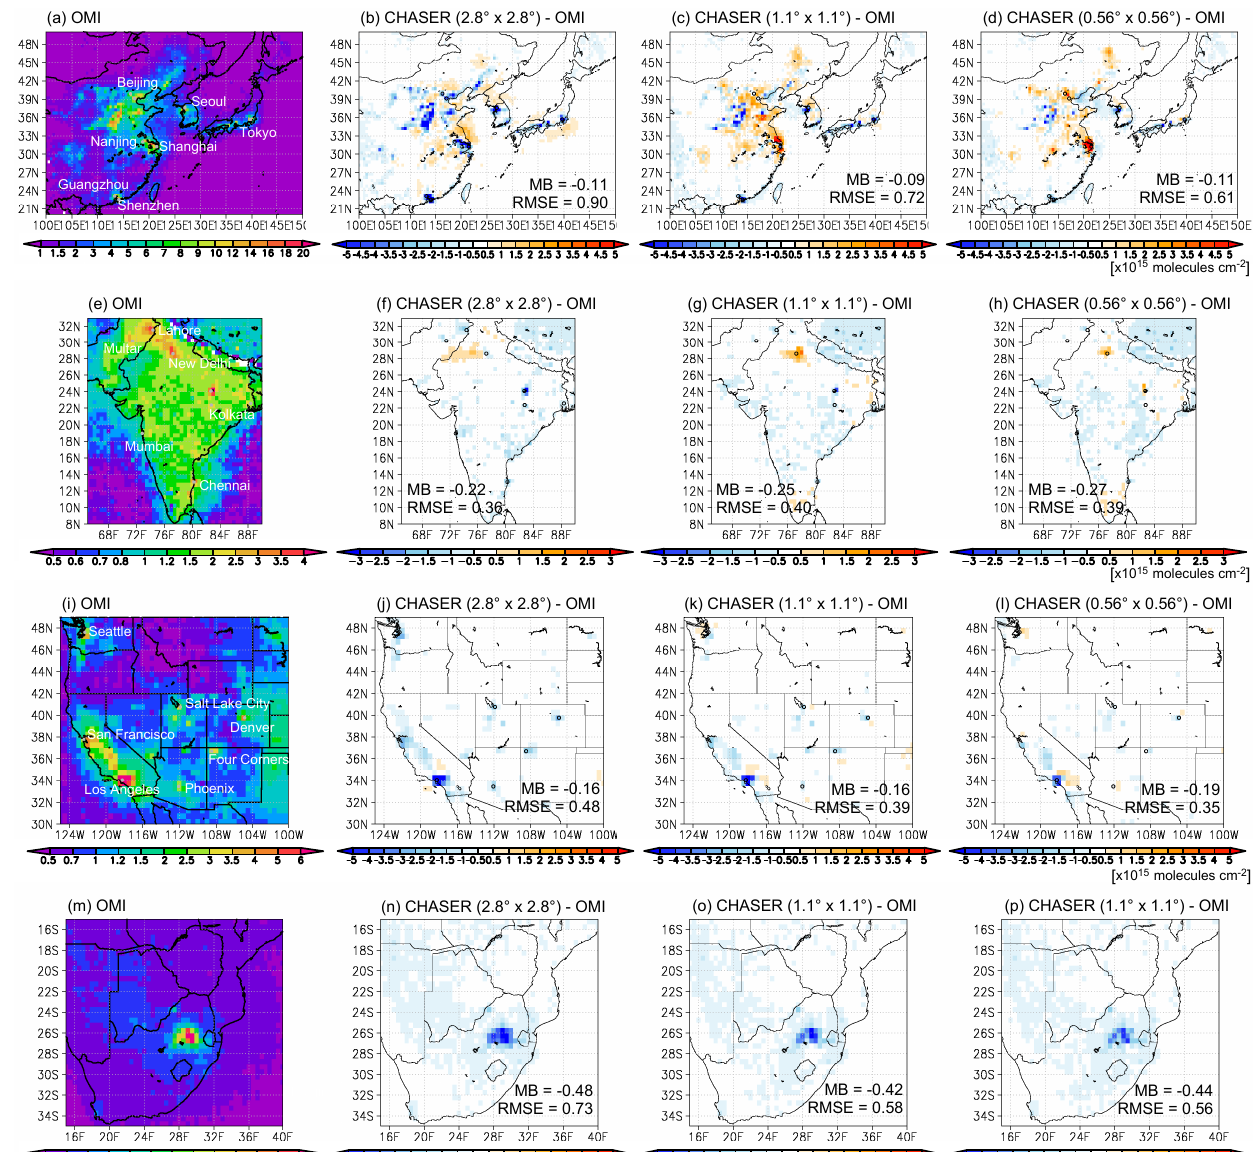
Figure 7. Tropospheric NO 2 column ( × 10 15 moleculescm − 2 ) from OMI retrievals (first column; a , e , i , m ) and differences between the model simulation at 2.8 ◦ (second column; b , f , j , n ), 1.1 ◦ (third column; c , g , k , o ), and 0.56 ◦ (fourth column; d , h , l , p ) resolutions and OMI retrievals over East Asia (first row; a–d ), South Asia (second row; e–h ), and the western United States (third row; i–l ) during JJA and over South Africa (forth row; m–p ) during DJF 2008. Observed and simulated fields are mapped onto a 0.5 ◦ bin grid. Regional mean bias (MB) and RMSE are also